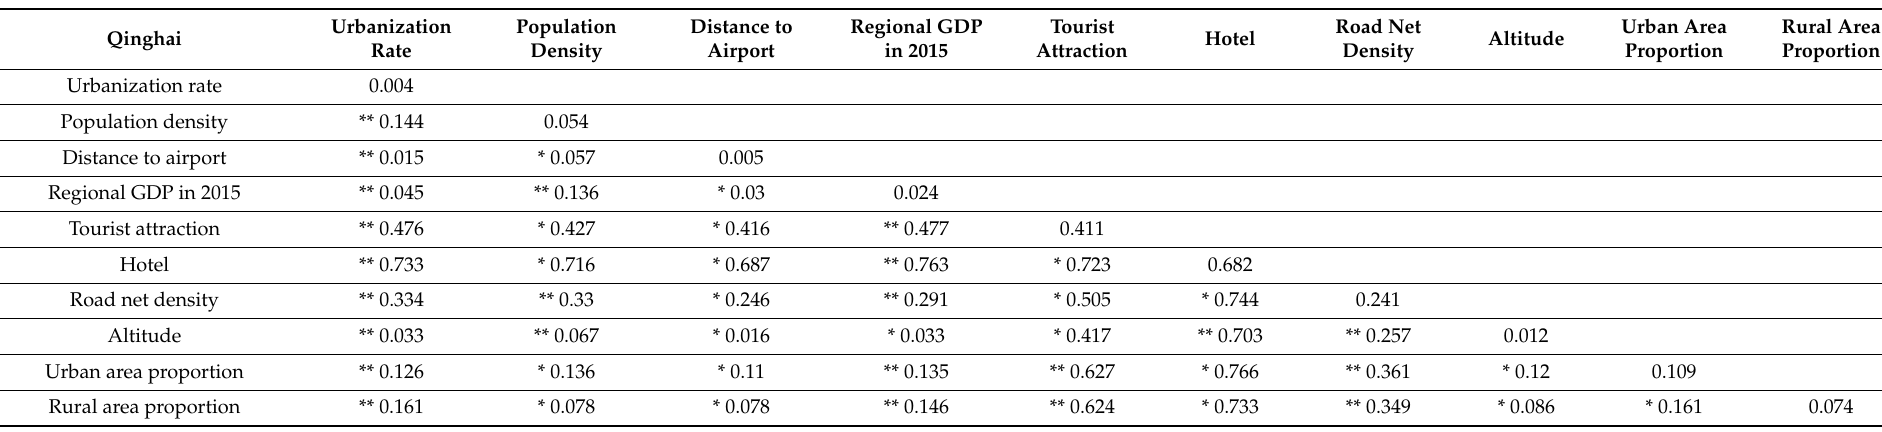
Table A1. q -Statistics of influential factor interactions in Qinghai.